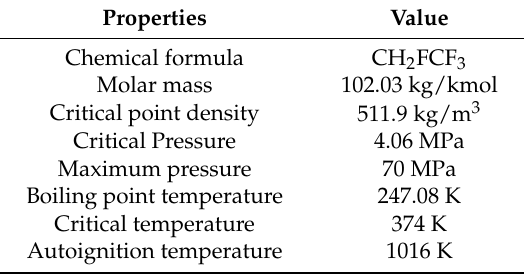
Table 1. Properties of R134a.